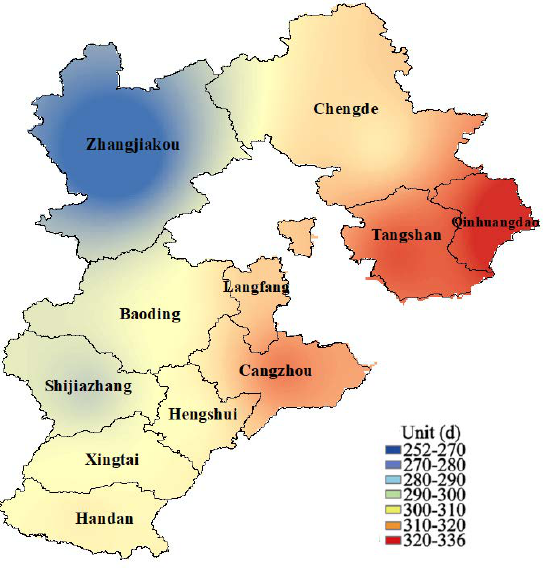
Fig. 1 Spatial distribution of accumulated rainfall in Hebei Province from 08:00 on July 18 to 08:00 on July 21, 2017